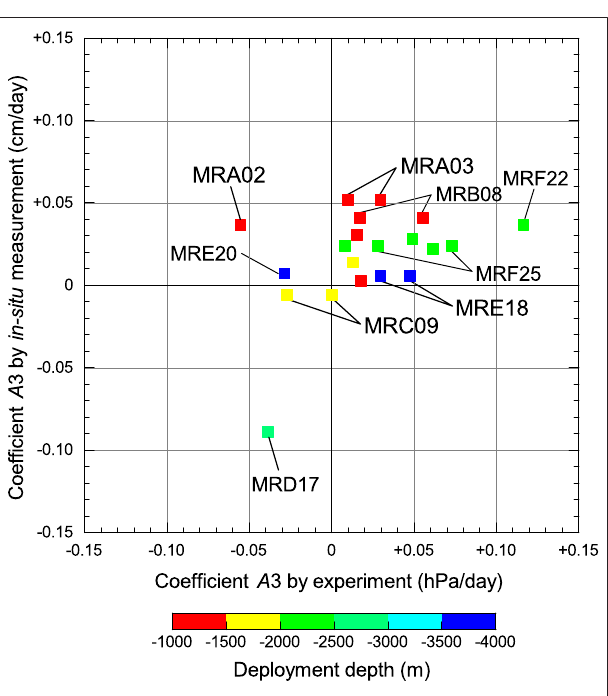
FIGURE 13 | Sensor drift rate from the in-situ measurements plotted against values from the experiments. Observatory names are indicated for some signi fi cant results and repeatedly examined sensors. Colors represent the deployment depth of each